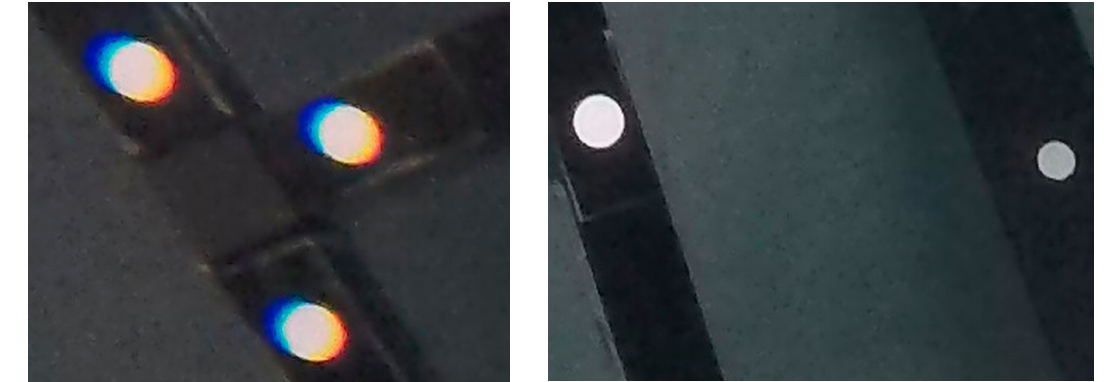
Figure 7. ( Left ) lateral CA visible in the underwater image. The centre of the image is to the bottom right. ( Right ) no CA is visible at points located at the centre of the image.